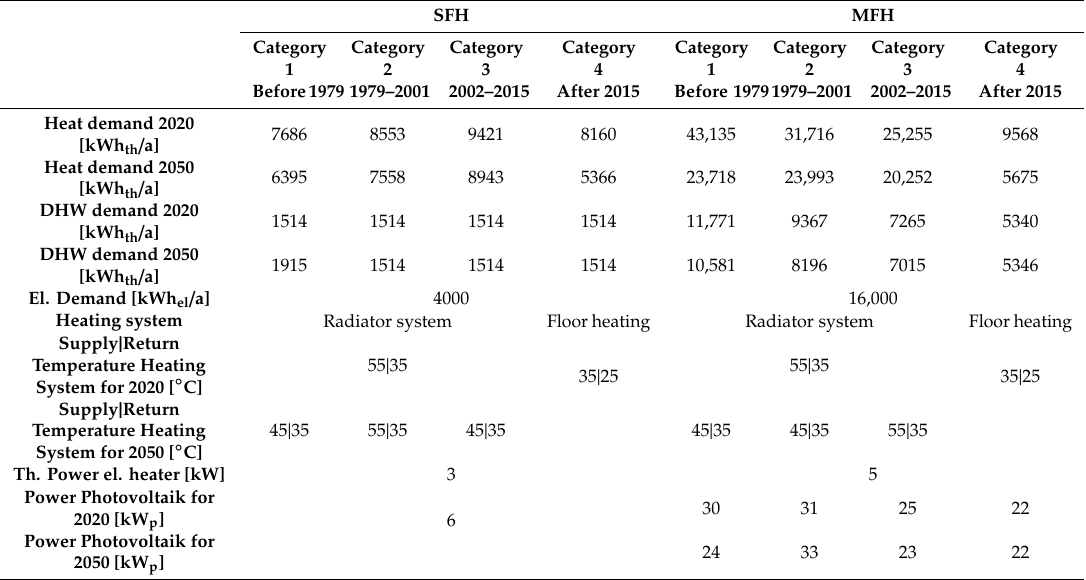
Table A1. Summary of input data for reference